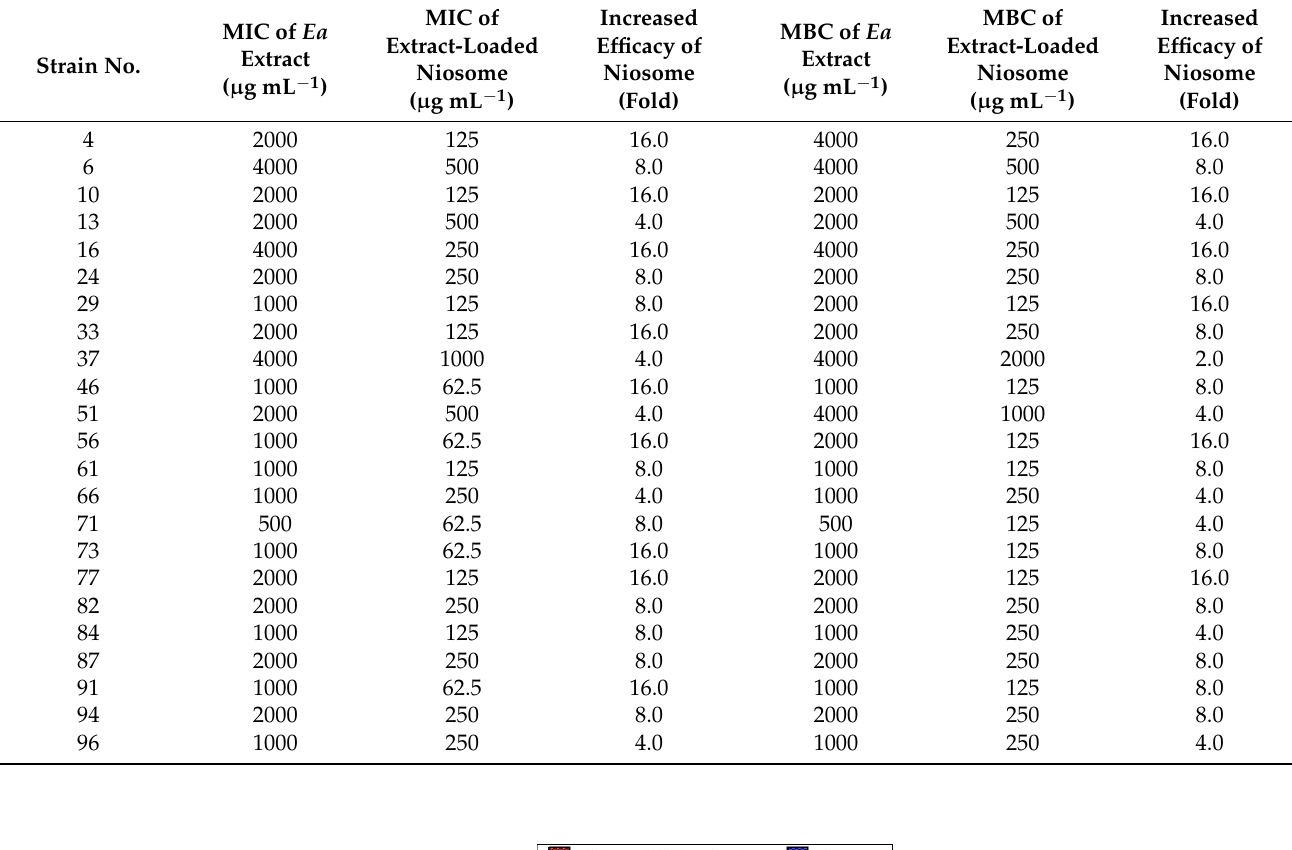
Table 5. MIC and MBC values of selected bacteria and niosome-encapsulated E. angustifolia extract.